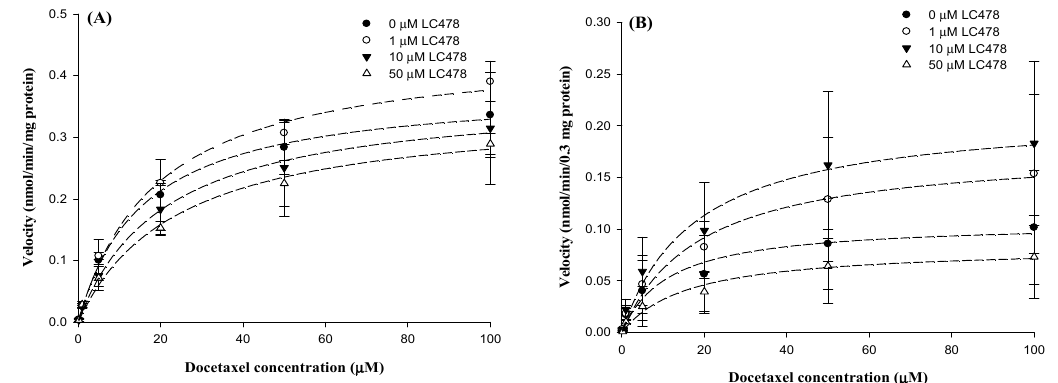
; n = 3), 10 ( (cid:72) ; n = 3) and 50 ( ∆ ; (cid:35)